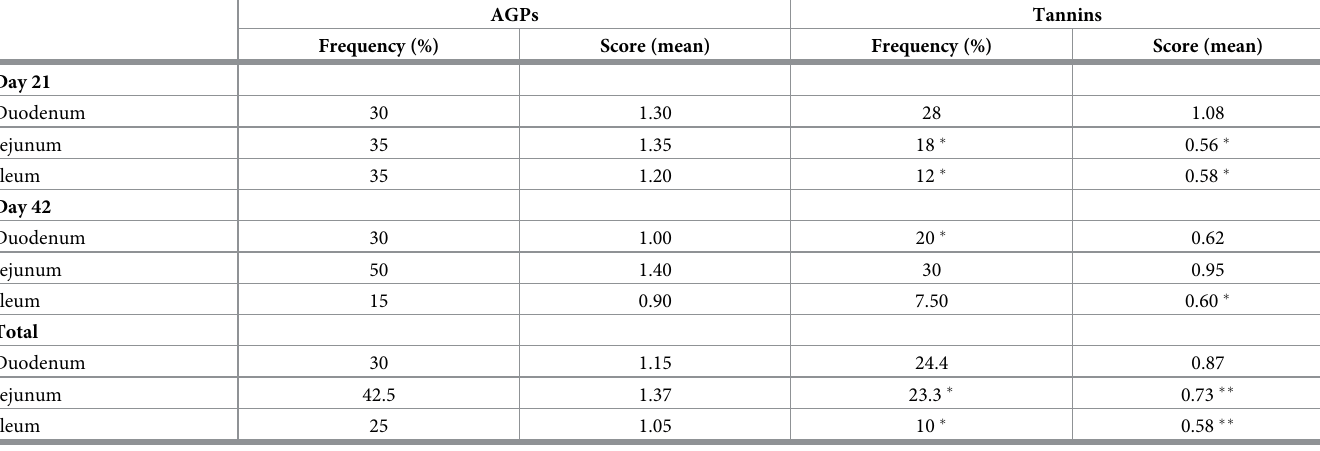
Table 2. Frequency and score of intestinal gross lesions1 (Experiment